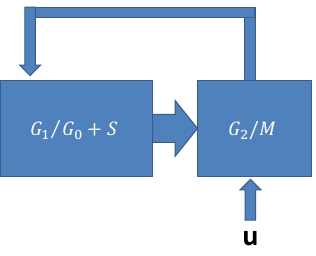
Fig. 1 A 2-compartment model with G 2 / M − specific cytotoxic